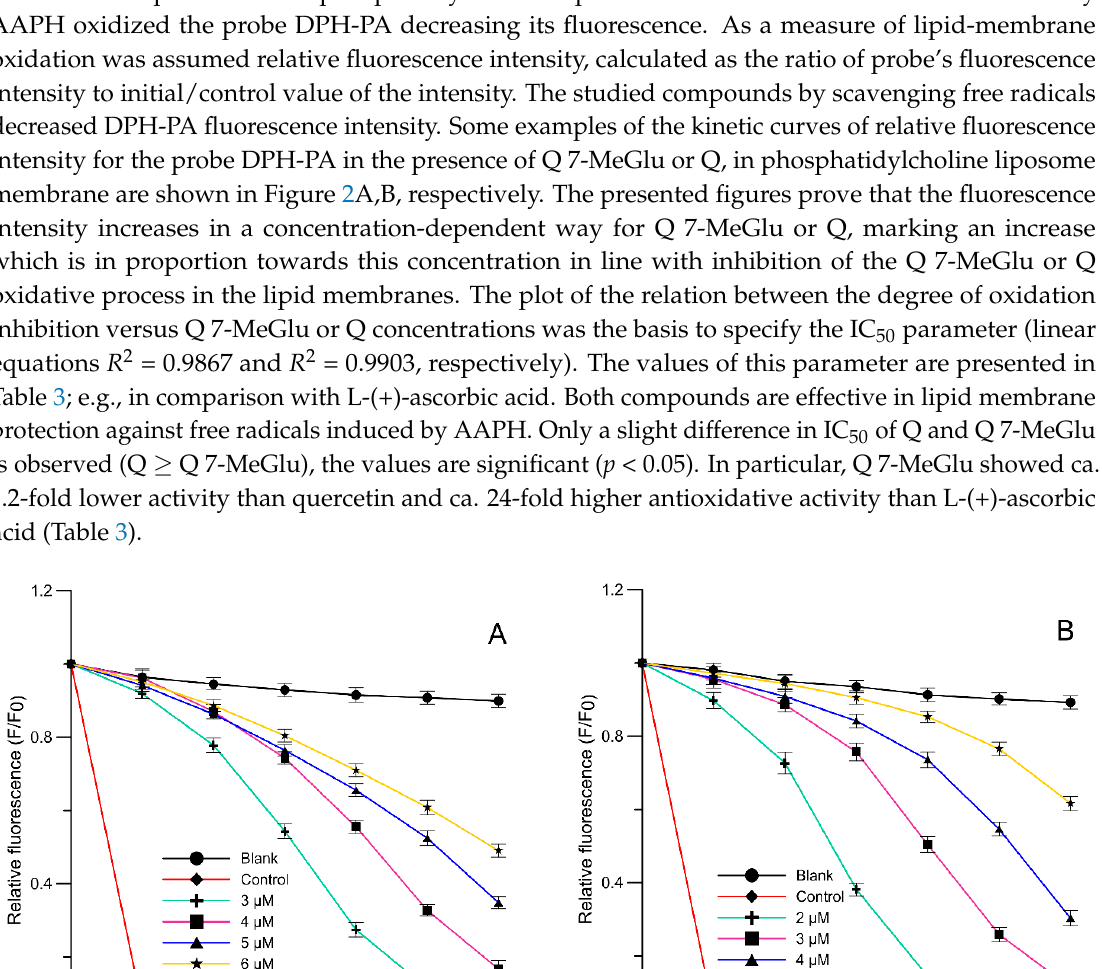
Figure 2. Relative fluorescence intensity of DPH-PA probe as a function of oxidation time for PC membranes and AAPH radicals in the presence of ( A ) quercetin 7- O - β - D -(4 ″ - O -methyl) glucopyranoside and ( B ) quercetin, for several concentrations. The relative changes in fluorescence intensity F / F 0 are a measure of the degree of lipid peroxidation ( F 0 —fluorescence in the control sample (oxidized by AAPH without study compounds), F —fluorescence of samples in the presence of study molecules). Blank sample -not oxidized by AAPH and without study compounds. Table 3. Compilation of IC 50 in the process of inhibition of AAPH induced oxidation of phosphatidylcholine liposomes and inhibition of COX-1 and COX-2 enzyme activity by quercetin 7- O - β - D -(4 ″ - O -methyl) glucopyranoside (Q 7-MeGlu) and quercetin. Means labeled with an asterisk (*) are significant ( p < 0.05) in the same row.